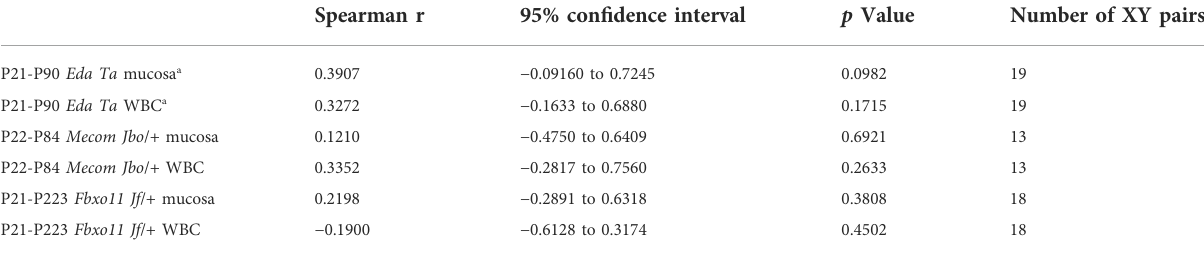
TABLE 1 Correlation between mucosal thickness and bulla cavity WBCs in contralateral